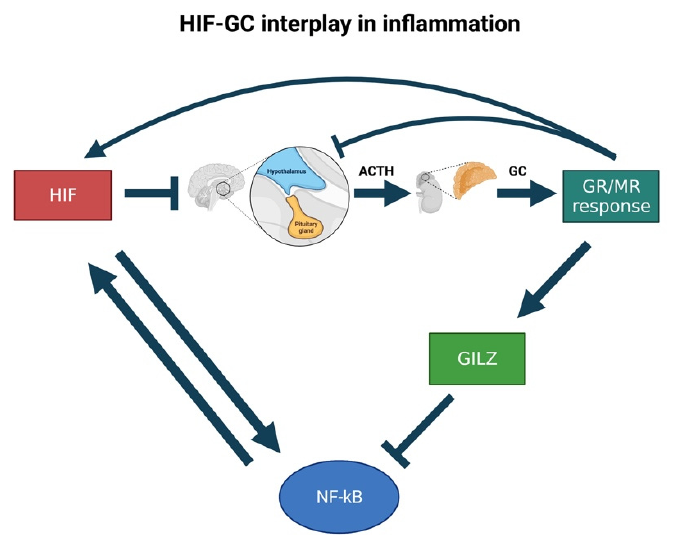
Figure 5. Speculative scheme of how the putative HIF-GC crosstalk occurs in inflammation. We speculate that HIF can negatively regulate pomca expression to control not only its own activity but also that of glucocorticoids throughout the inflammatory process. Indeed, if not properly controlled, glucocorticoids could upregulate GILZ, whose overexpression has been demonstrated to suppress NF- κ B activation. Since the latter can, in turn, increase the transcription of HIF-1 α in response to hypoxic and inflammatory stimuli, its downregulation would hamper HIF activation and avoid essential pro-inflammatory HIF-mediated effects to